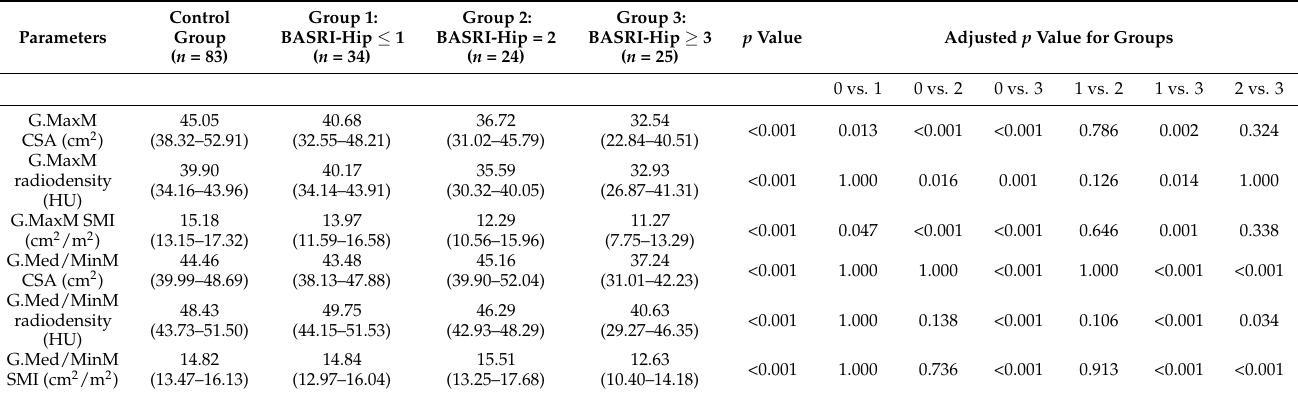
Table 3. Comparison of muscle parameters between patients with ankylosing spondylitis versus controls.